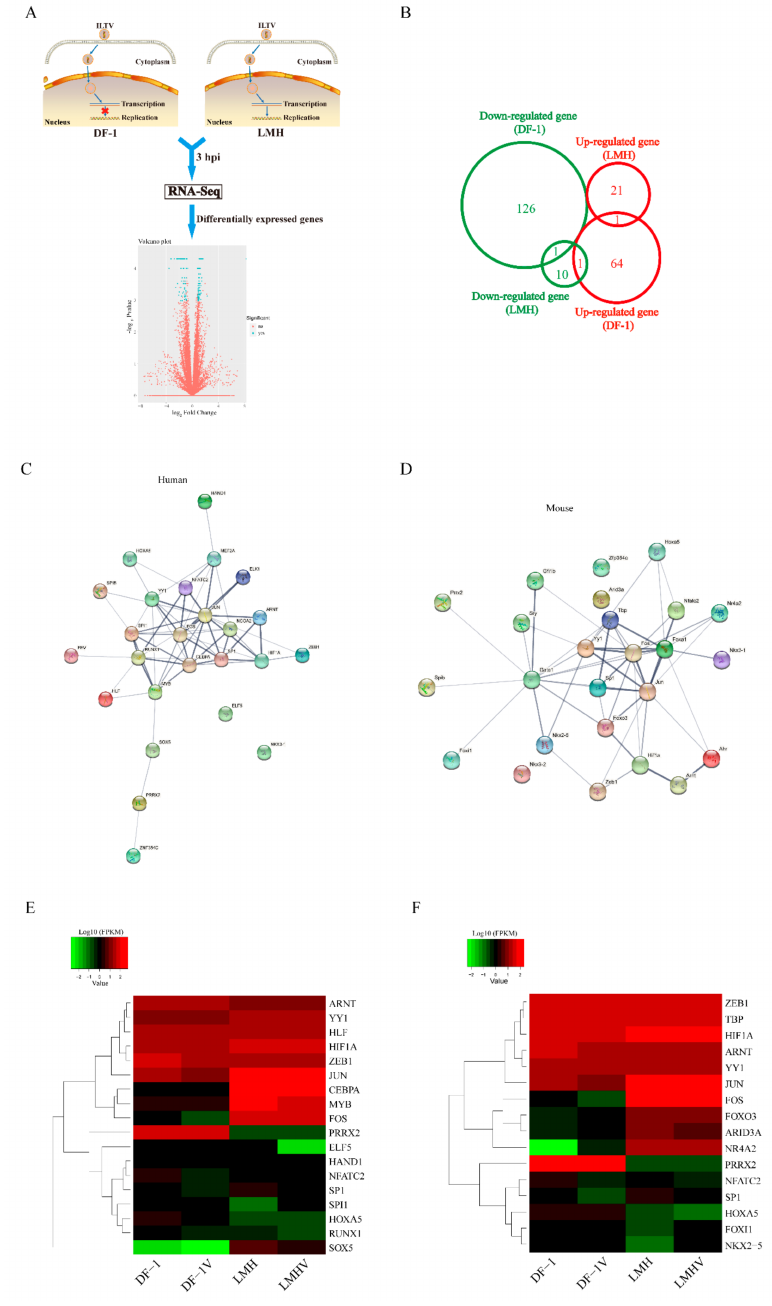
Figure 1. Bioinformatics analysis reveals AP-1 as a central modulator of host molecular events upon ILTV infection. ( A ) Schematic diagram showing the experimental design of the genome-wide transcriptome analysis. The ILTV-susceptible but nonpermissive chicken cell line DF-1, which only supports transient viral gene transcription, and the ILTV-permissive chicken cell line LMH were used as the models. The DEGs identified in LMH cells and DF-1 cells three hours after ILTV infection based on RNA-Seq were further analyzed. Volcano plot showing the log 2 fold change values (X axis) by − log 10 corrected p -values (Y axis) for all genes. The genes that were significantly altered ( p <